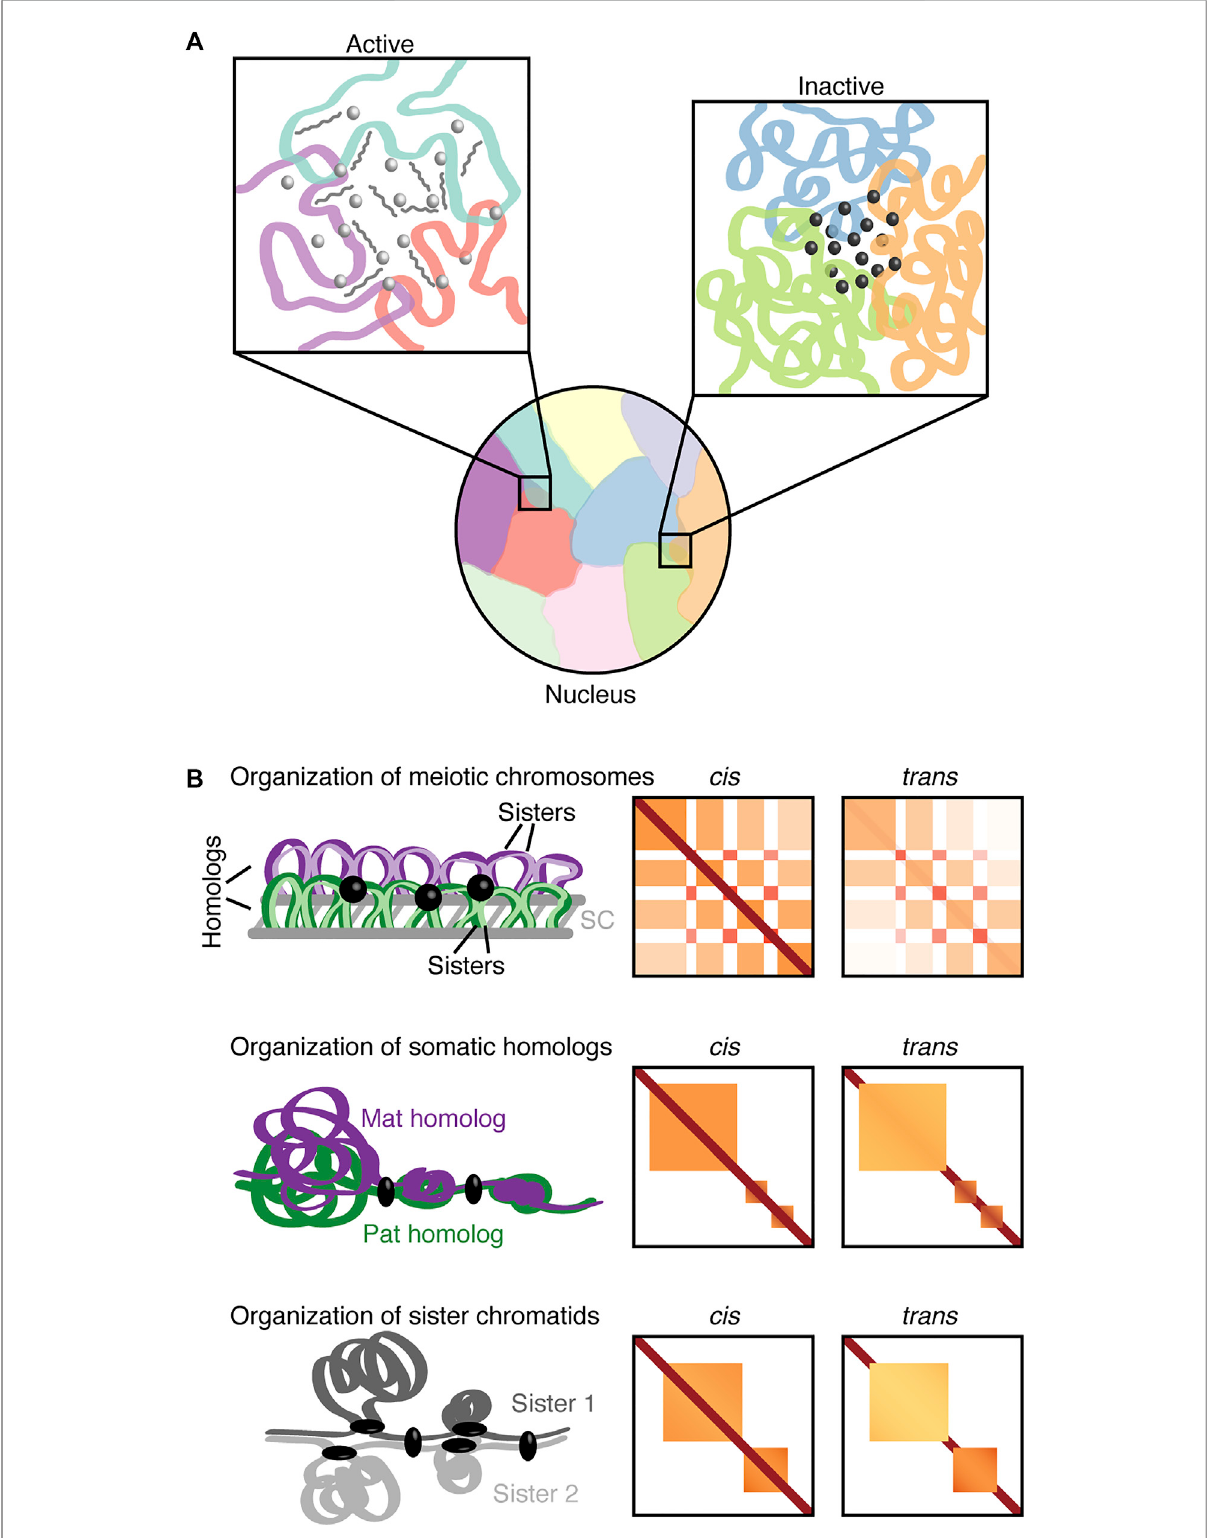
FIGURE 1 Nuclear inter-chromosomal interactions. (A) Chromosomes can occupy discrete territories with a tendency for neighboring chromosomes to intermingle. The left inset depicts an inter-chromosomal hub associated with open chromatin and active transcription with transcription factors